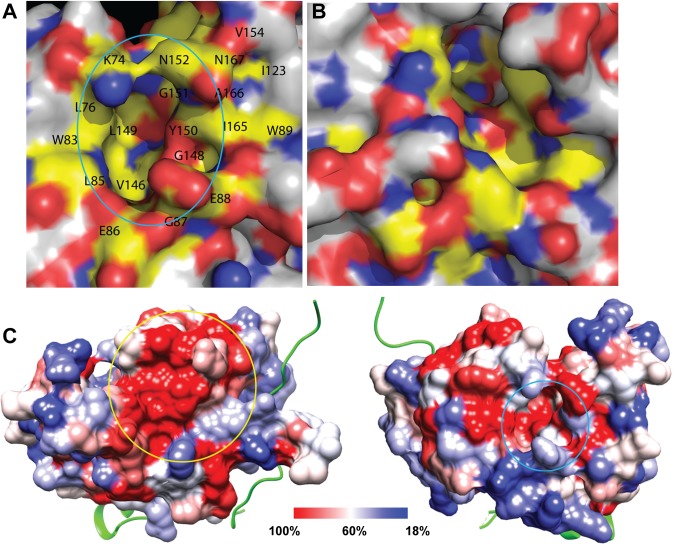
A pocket unique to the inactive NS2B-NS3 structure.(A) Surface representation of the unique pocket of the inactive NS2B-NS3 structure. (B) Surface representation of the active NS2B-NS3 structure at the same area. Surface color was according to atomic color as follows unless otherwise stated: oxygen, red; nitrogen, blue, carbon of residues involved in pocket formation, yellow; other carbon, white. (C) Mapping of sequence conservation to surface of the DENV2 NS3 protease domain (PDB code: 2FOM); the structure is viewed from two angles, showing features in different regions. Left: active site surface (yellow circle). Right: the unique pocket (cyan circle) of the inactive NS2B-NS3 structure. The surface is colored according to sequence conservation, resulting from the multiple sequence alignment. NS2B is displayed as a cartoon representation (green).